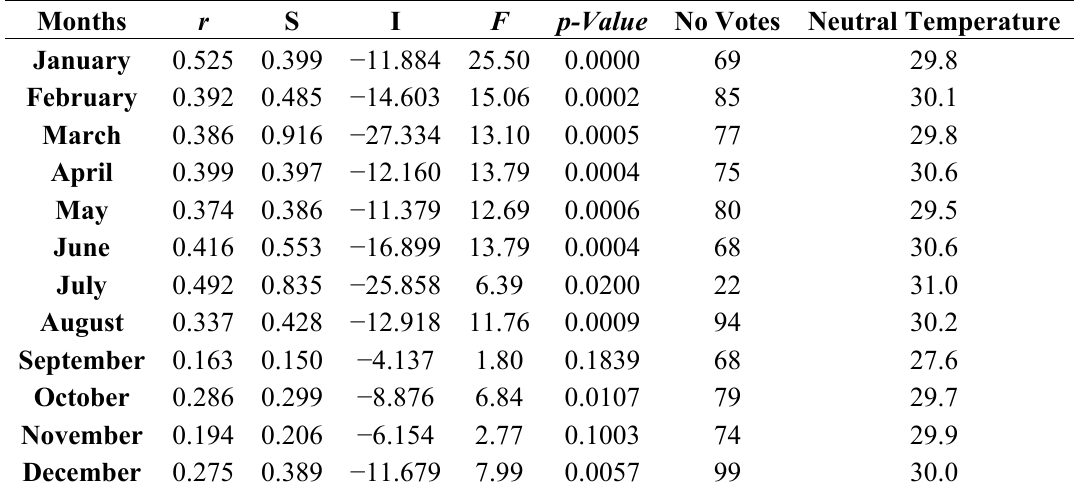
Table 2 . Determination of monthly neutral temperatures.